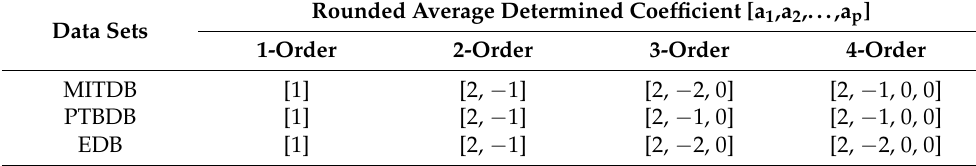
Table 6. Rounded Average Determined Linear Prediction